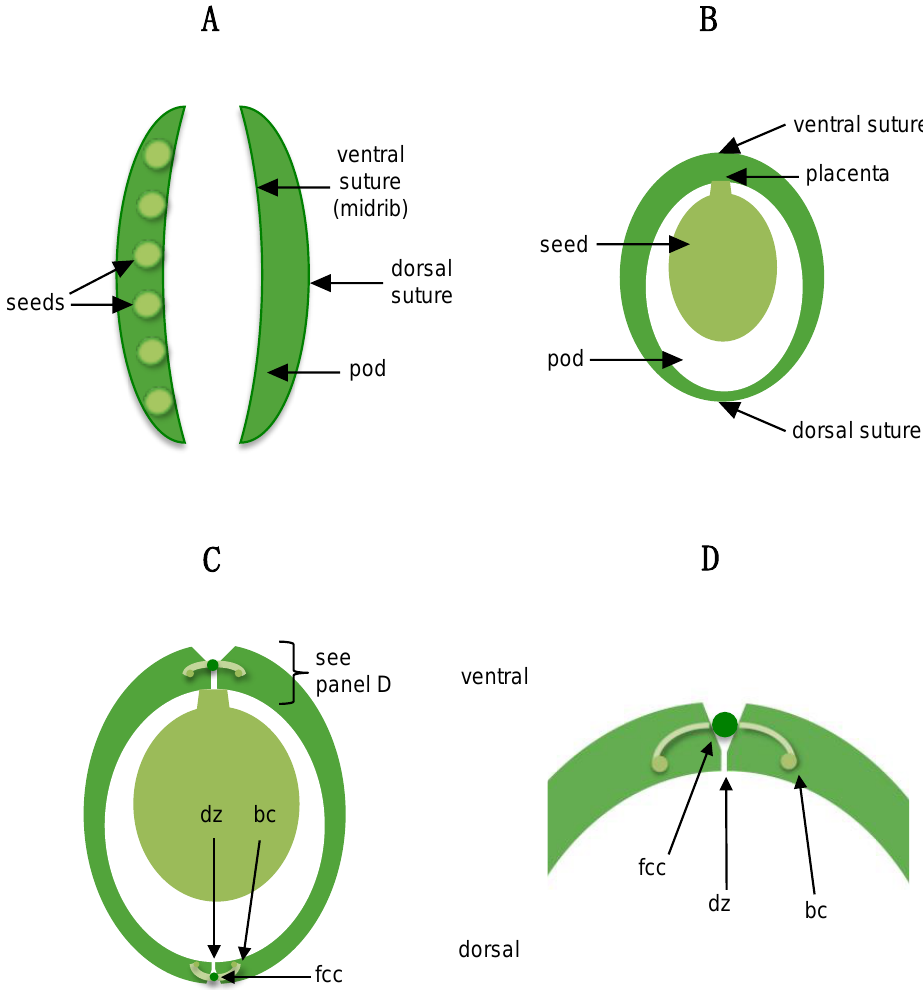
Figure 2. Structure of a legume pod. ( A ) Cross section of the pod in which the seeds are enclosed. ( B ) Cross section of the pod. Seeds are attached to the midrib through the placenta. ( C , D ) Magnified views of the cross section. bc: bundle cap, dz: dehiscence zone, fcc: fibre cap cells. The figure is derived from